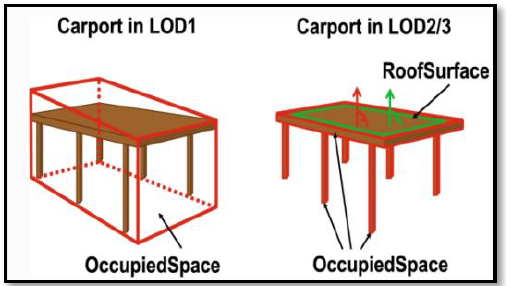
Figure 3 : CityGML 3.0 overview Figure 4 : Occupied and Unoccupied Space (Kutzer et al., 2020)